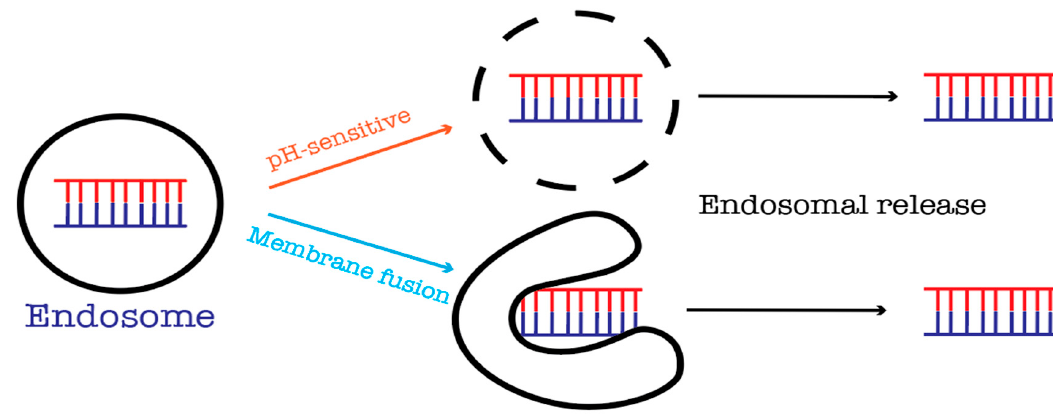
Figure 7. Ways to overcome endosomal entrapment.